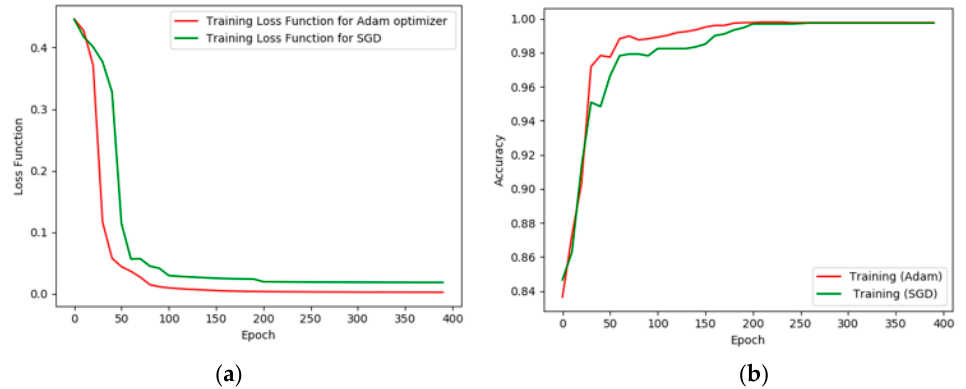
Figure 9. ( a ) Comparison of stochastic gradient descent (SGD) and adaptive moment estimation (Adam) optimizer and influence on the loss function. ( b ) Comparison of SGD and Adam optimizer and influence on the accuracy.